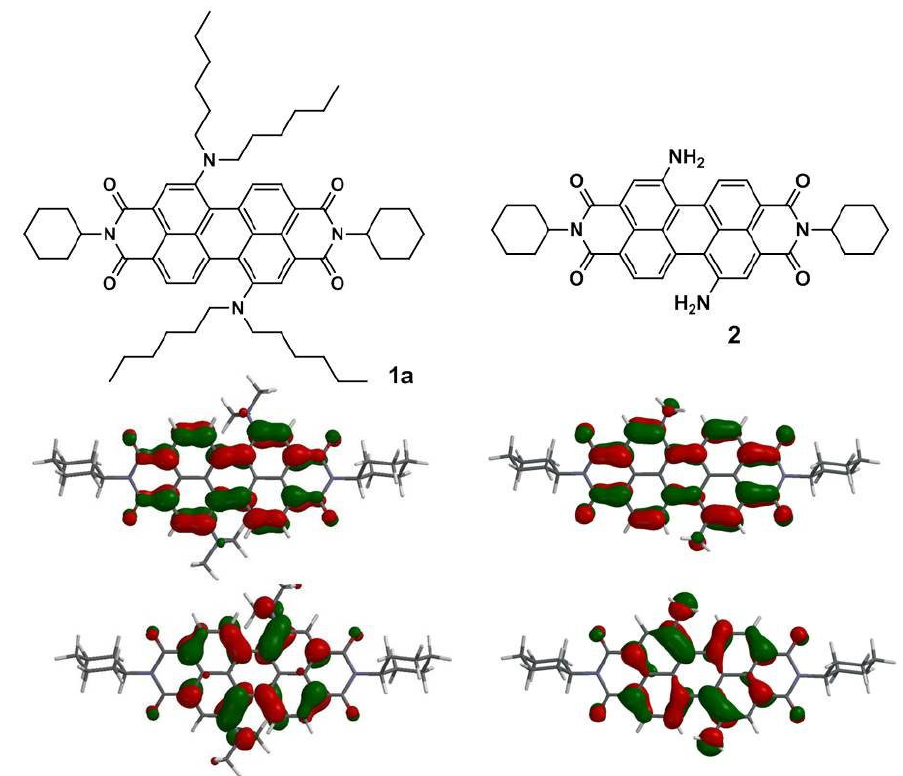
Figure 6. Calculated frontier orbitals for 1a and 2 . The upper structures show the lowest unoccupied molecular (LUMOs) and the lower ones show the highest occupied molecular orbitals (HOMOs). Methyl groups replace the hexyl groups for